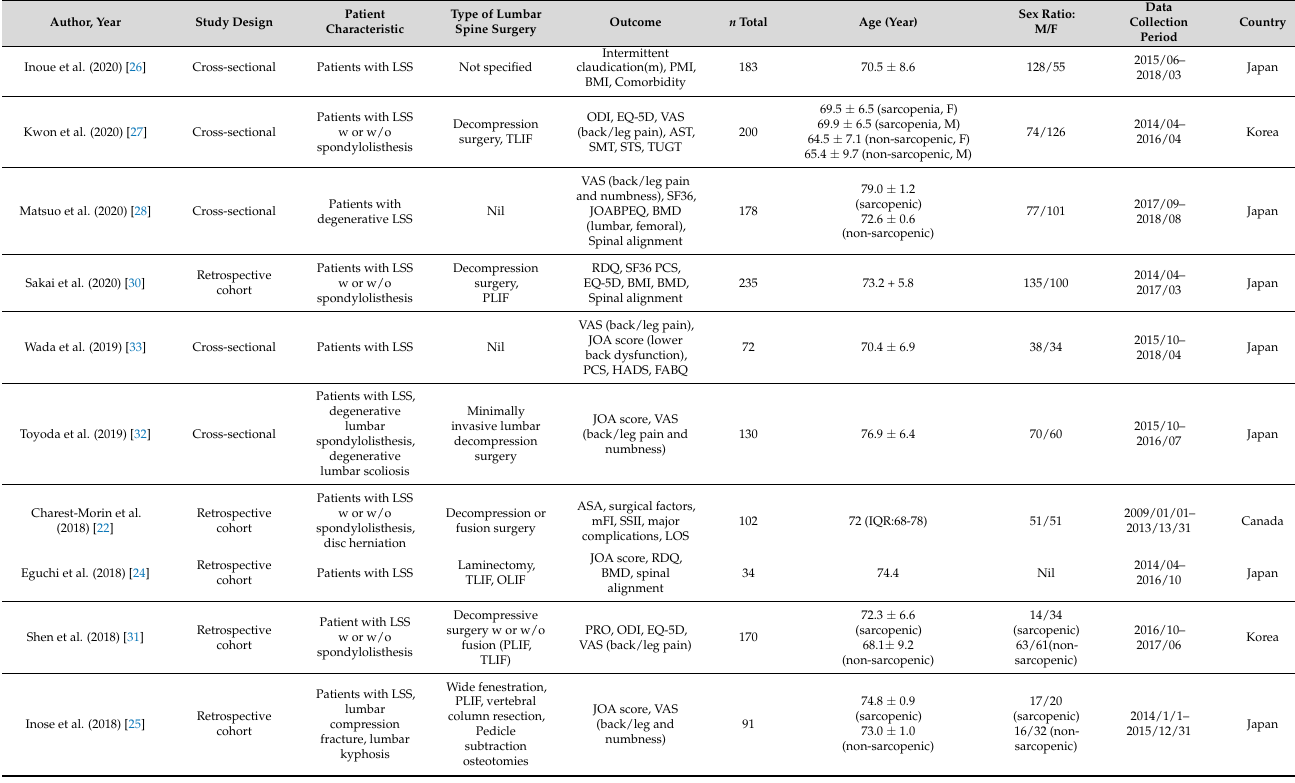
Figure 1. Preferred Reporting Items for Systematic Reviews and Meta-Analyses (PRISMA) flow diagram for the study selection process. Table 1. Characteristics of the Included